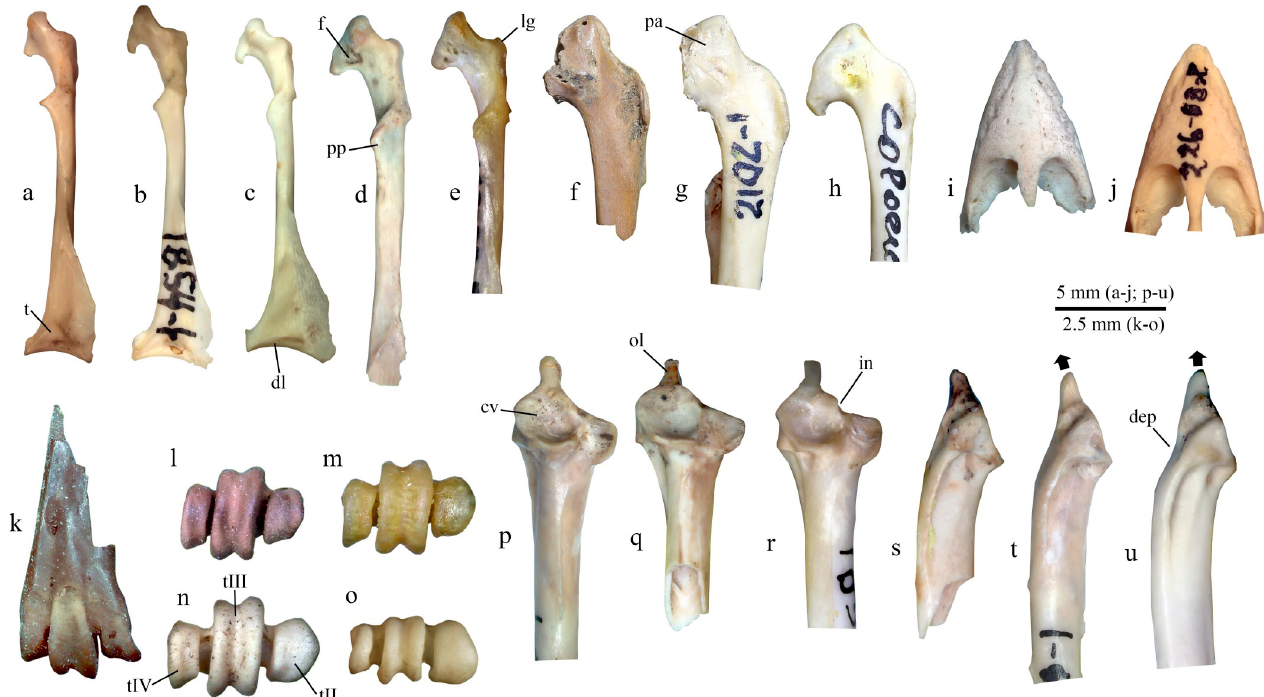
Fig 3. Late Quaternary bones of perching birds (Passeriformes) from Istykskaya cave compared with selected modern taxa. a–h , coracoids; i, j , rostra maxillae; k–o , tarsometatarsi; p–u , ulnae. a–e, i–k , dorsal views; f–h , s–u , ventral views; l–o , distal views; p–r , cranial views; a , Motacilla ? citreola , specimen IST 2019-3-74; b , M . citreola (modern; specimen PIN 168-3-1); c , Acanthis flavirostris (modern, specimen PIN 226-63-1); d , Eremophila alpestris , specimen IST 2018-2/3-SU7-15; e , o , E . alpestris (modern, specimen PIN 165-77-1); f , Pyrrhocorax pyrrhocorax , specimen IST 2019-2-26; g , Pyrrhocorax pyrrhocorax (modern, specimen PIN 244-65-1); h , Corvus modenula (modern, specimen PIN 244-68-1); i , Leucosticte sp., specimen IST 2019-3-42; j , Leucosticte brandti (modern, specimen PIN 226-68-2); k, l, q, s , Monticola saxatilis , specimen IST 2019–1.1–15 ( k, l ) and IST 2019-3-44 ( q, s ); m , M . saxatilis (modern, specimen PIN 185-186-1); n , p, t , M . solitarius (modern, specimen PIN 185-189-1); r, u , Turdus atrogularis (modern; specimen PIN 185-273-3). Abbreviations: cv , cotyla ventralis; dep , depression; dl , dorsal lobe of the facies articularis sternalis; f , foramen on the dorsal side of processus acrocoracoideus; in , incisura; lg , labrum glenoidale; ol , olecranon; pa , processus acrocoracoideus; pp , processus procoracoideus; t , tuberculum; tI-tIII , trochleae metatarsorum I-III. Arrow indicate the orientation of the olecranon.